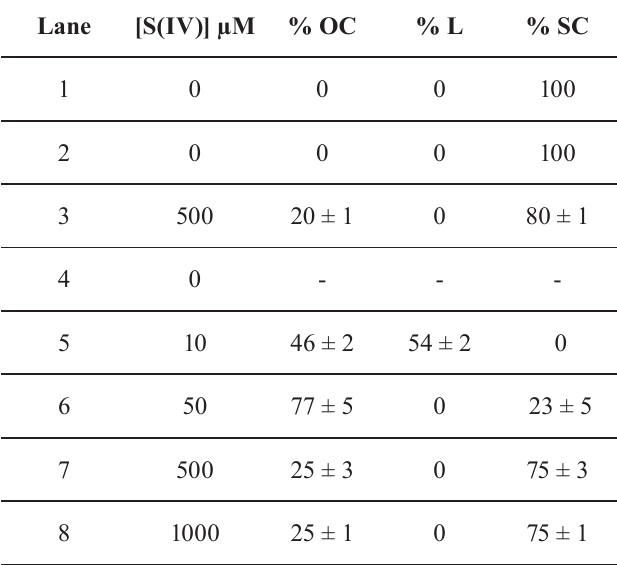
TABLE IV – % of OC, L and SC forms of pUC-19 DNA (experimental conditions according to Figure